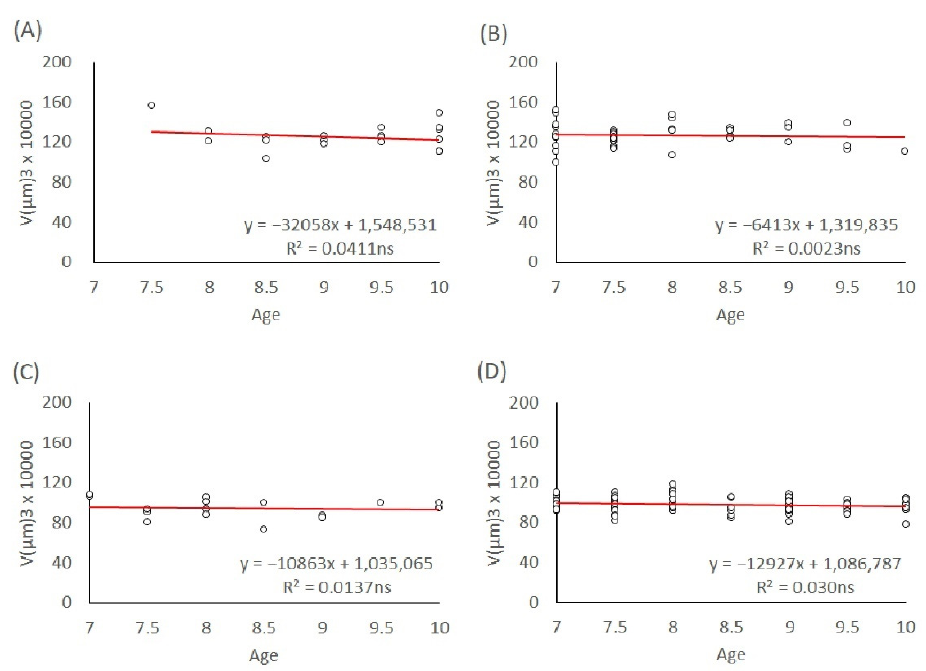
Figure 5. Linear regression of egg size in the maternal age group of 7–10-day-old mothers. ( A ) L1 male eggs, ( B ) L1 female eggs, ( C ) T male eggs, and ( D ) T female eggs. The significance level of the slope: ns (not significant).